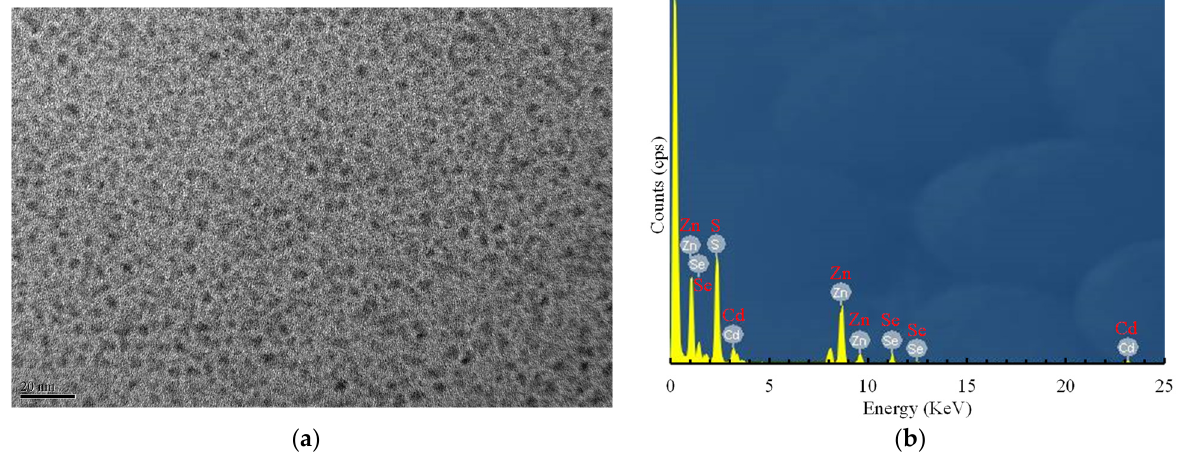
Figure 1. ( a ) TEM image of CdSe/ZnS QDs at a resolution of 20 nm and ( b ) EDX analysis results for CdSe/ZnS QDs.